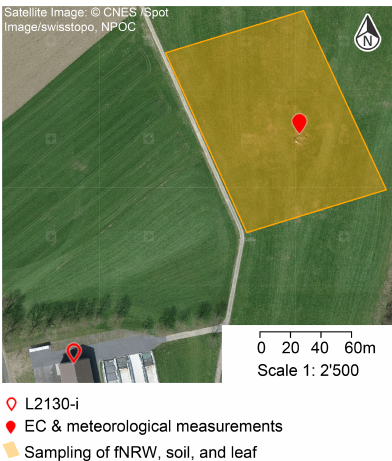
Figure A1. Measurements and sampling at the Chamau site (satel- lite image: © CNES /Spot Image/swisstopo, NPOC). “L2130-i” represents the isotopic composition and mixing ratio measurements for ambient water vapor; EC, eddy covariance; fNRW, non-rainfall water on